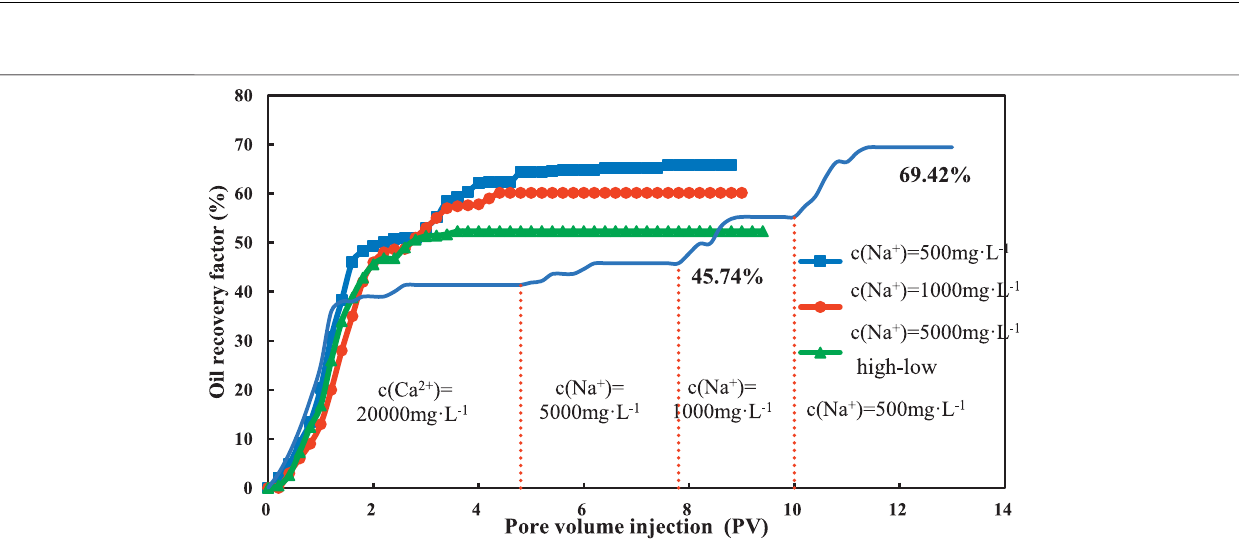
FIGURE 13 | Variation curve of the recovery degree of montmorillonite sand packs under different displacement methods.